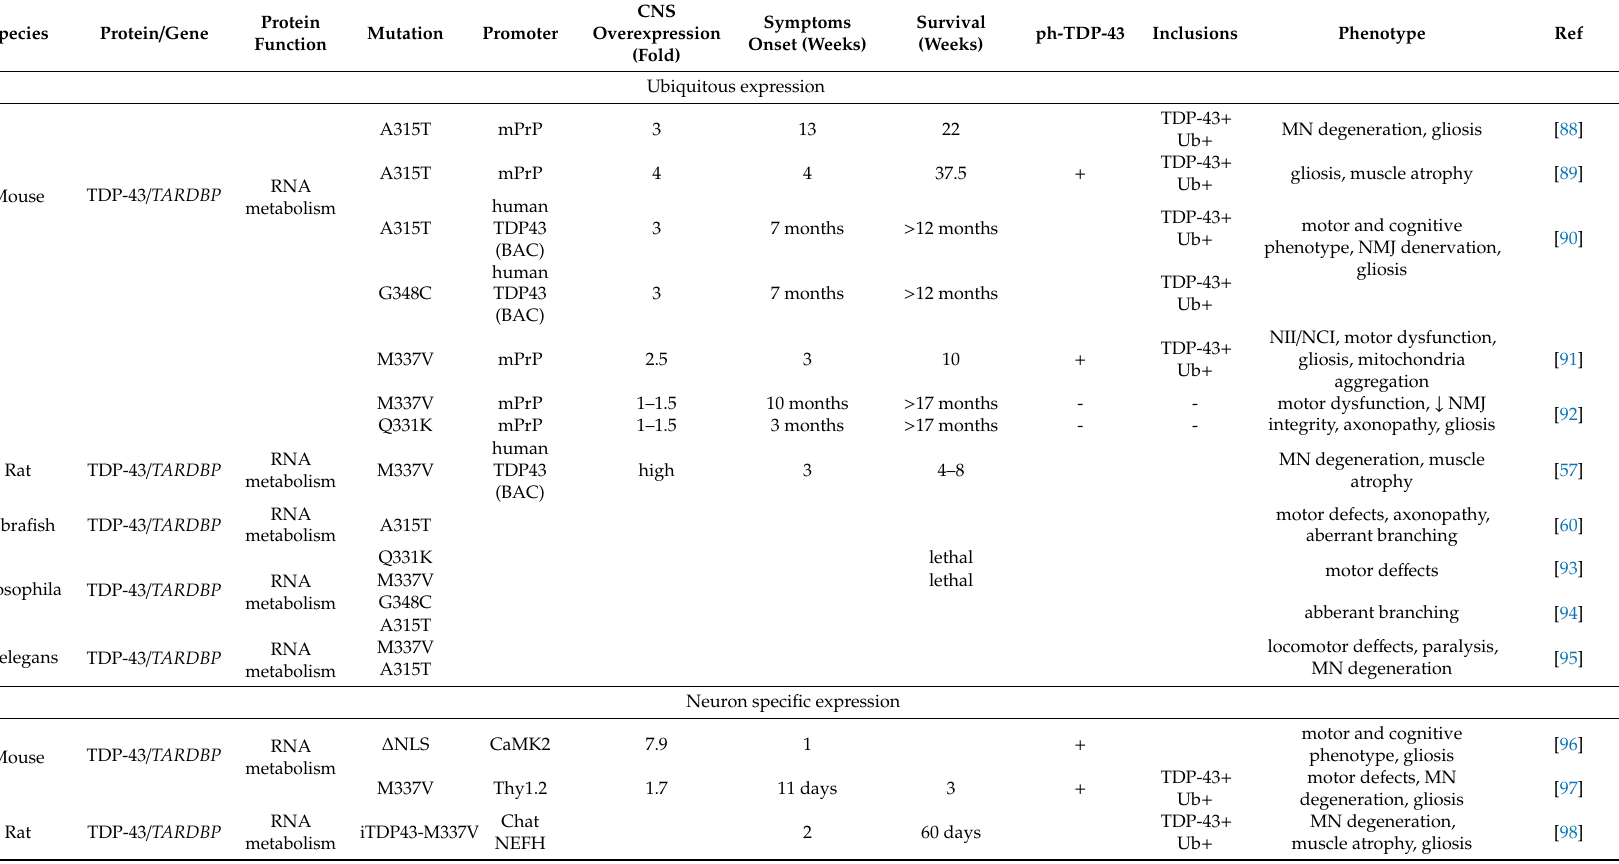
Table 2. Summary of representative TDP-43 animal models of amyotrophic lateral sclerosis